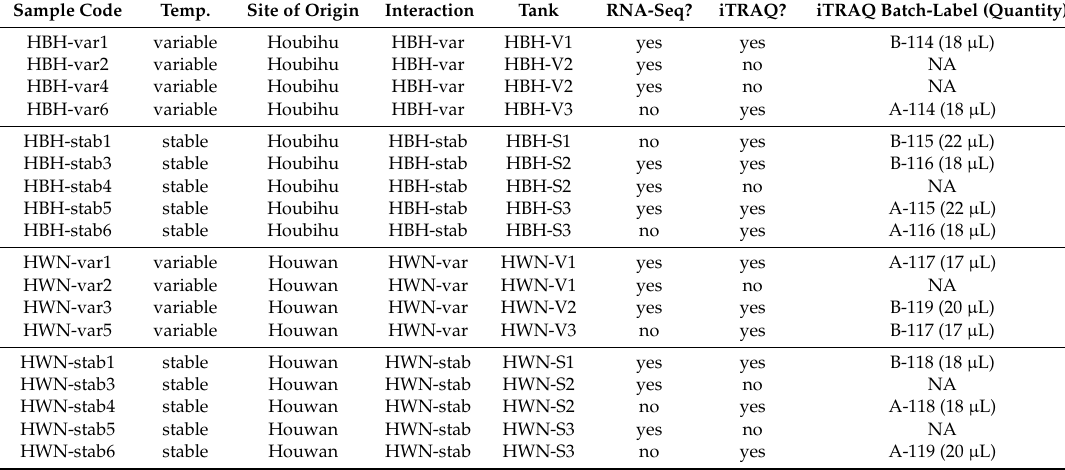
Table 2. Samples analyzed by transcriptomic (RNA-Seq [31]) and proteomic (iTRAQ; herein) approaches. Please note that (1) six samples were analyzed by both methodologies, and (2) all colonies were of the same genotype. NA = not applicable. temp. =